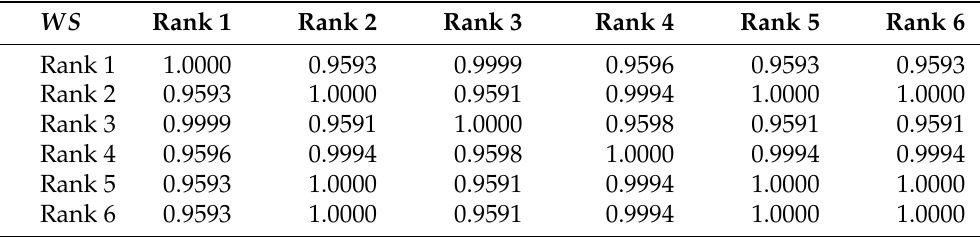
Table 11. Correlation matrix for WS values for compromise ranking candidates with consideration of sample smartphones.